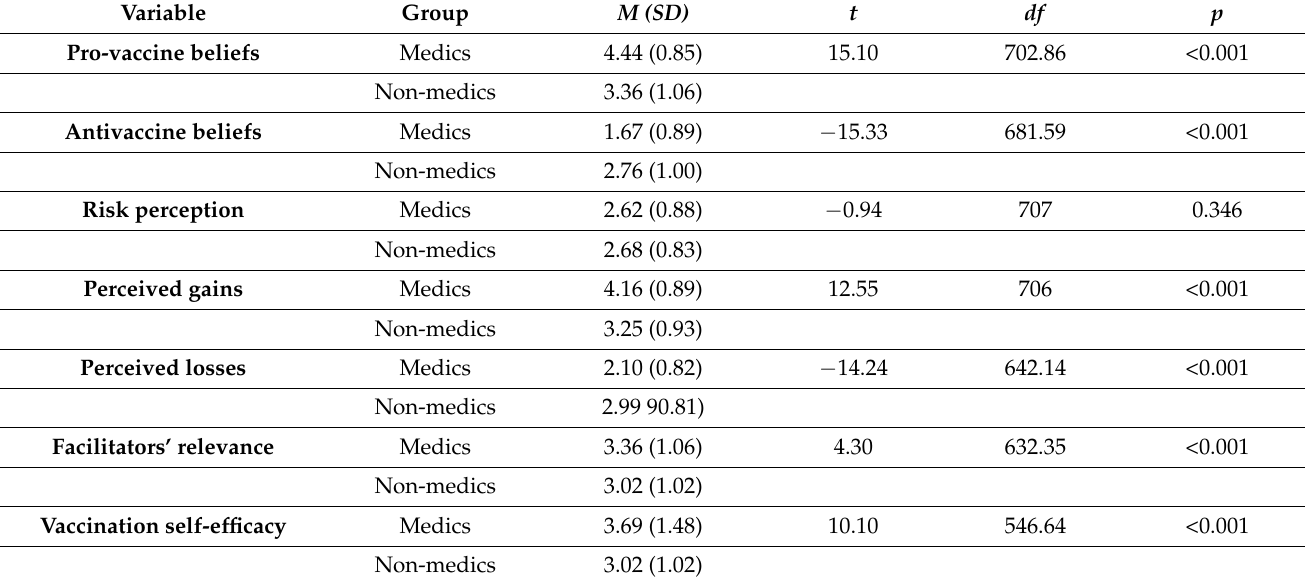
Table 1. Comparison of predictors in medics ( n = 301) and non-medics ( n =